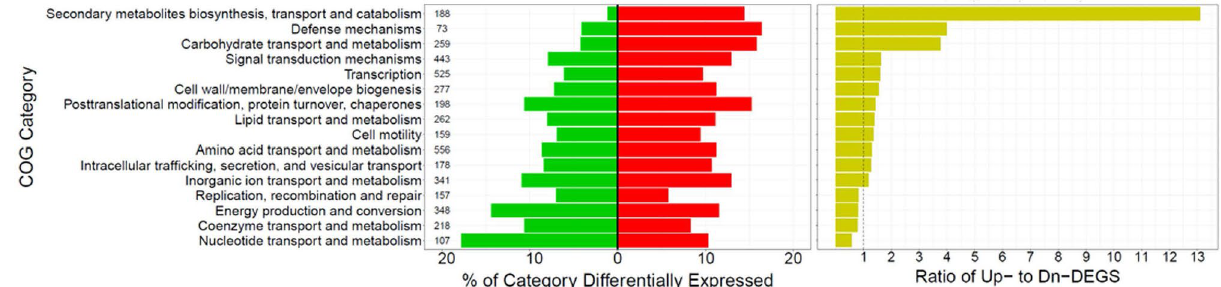
Figure 4. COG categories differentially expressed between biofilm and acute wound infection (D5&D9:H2&H6). The percent down-regulated (green) and up-regulated (red) genes in each COG category are graphed (right panel). The COG categories are ordered by descending ratio of up- to down-regulated genes (yellow, left panel). The numbers in the left panel are the counts of genes per COG category ( Pseudomonas Genome DB , PAO1 COG